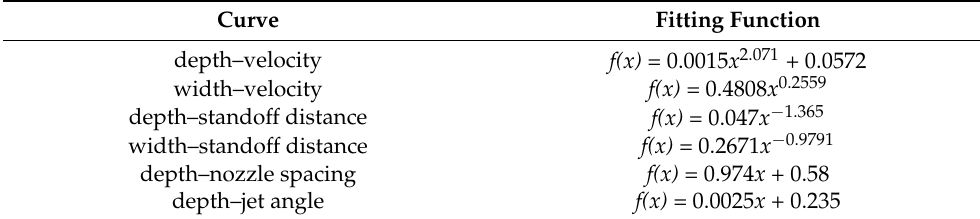
Table 9. Relation fitting